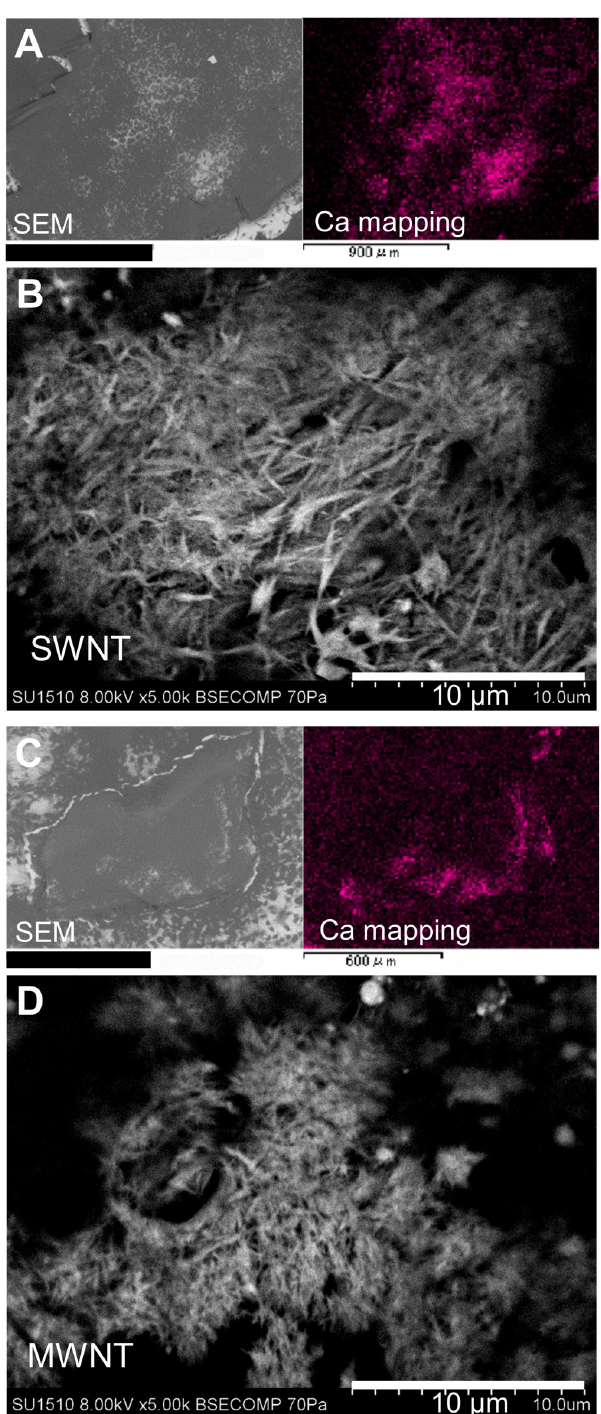
Fig 7. SEM-EDX analysis of calcium phosphate deposited by MSCs on SWNTs and MWNTs. The samples were observed by SEM and the localization of calcium was analyzed on (A, B) SWNTs and (C, D) MWNTs by the EDX system. A and C are low magnification images using SEM (left) and calcium mapping of the same view (right). B and D are high magnification images using SEM. Scale bar: (A) 900 μ m, (C) 600 μ m.